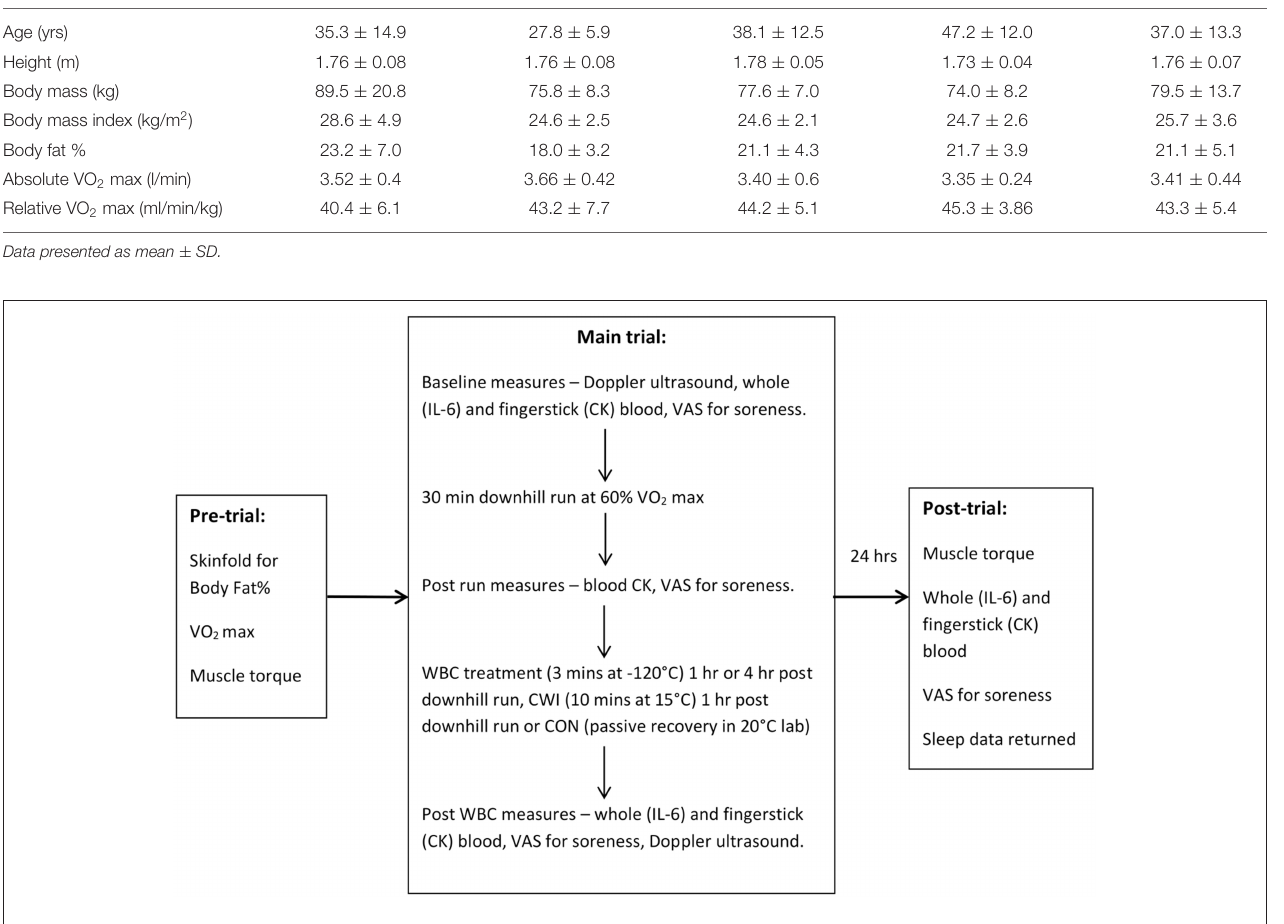
FIGURE 1 | Protocol summary of measures for each trial. Sleep was also assessed for 3 consecutive nights prior to main trial and night following. WBC, Whole Body Cryotherapy; CWI, Cold Water Immersion; CON, Control; CK, creatine kinase; VAS, visual analog